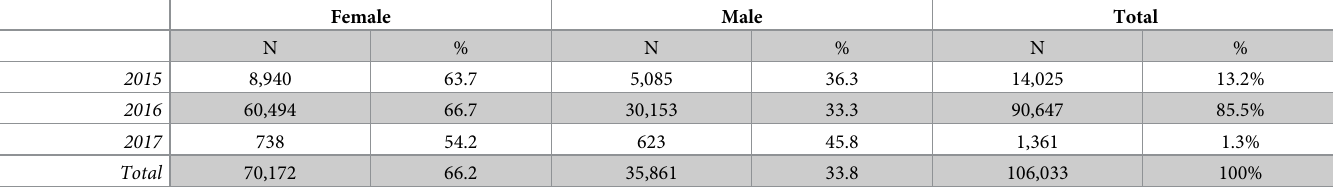
Table 1. Number of ZVD cases by sex in Colombia. Epidemiological week 32 of 2015—epidemiological week 24 of 2017. Female